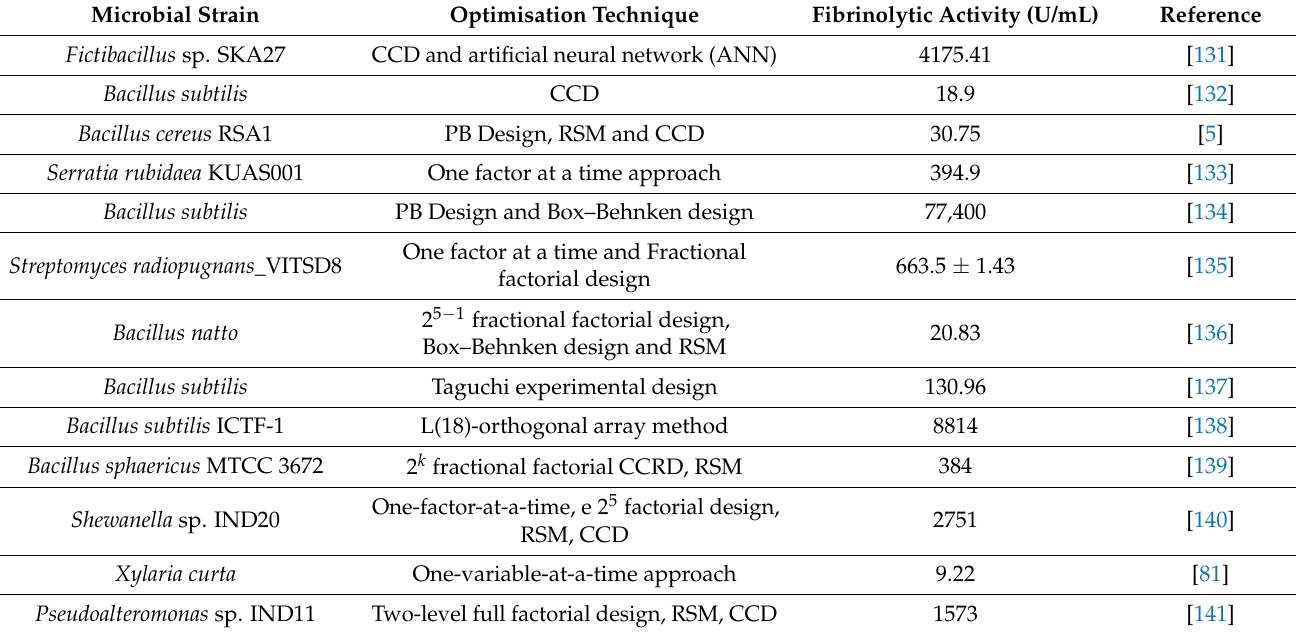
Table 2. Process optimisation techniques for optimal production of fibrinolytic